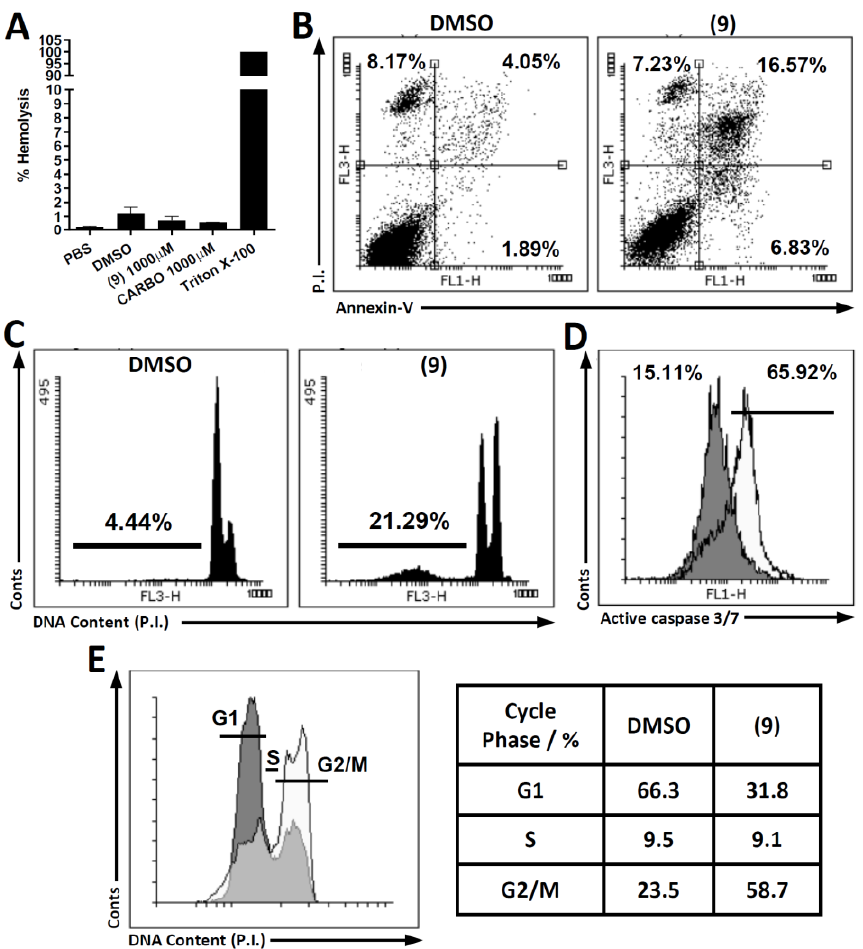
Figure 1. ( A ) Hemolytic activity of compounds at 500 µ M (approximately 10 × IC 50 ). One‑way ANOVA with Dunnett’s post‑test was performed where all columns were significantly different from the control (Triton X) with p < 0.0001. ( B ) Analysis of phosphatidylserine exposure 48 h after plating. Cells were stained with annexin‑V conjugated to FITC and P.I. and were analyzed by flow cytometry. ( C ) Analysis of cell death by propidium iodide (PI) staining. After 48 h of treatment, cells were trypsinized and stained with propidium iodide in the presence of NP‑40. The percentage of cell death (SubG0 DNA content) is indicated. ( D ) Flow cytometry data representative of caspase 3/7 activity. SCC9 cells were treated with the equivalent of 2 × IC 50 of compound 9, and DMSO was used as a control for 48 h of treatment. The activity of caspase 3/7 of the cells increased significantly under 9 treatment compared to the control. ( E ) Differences in cell cycle distribution. Cell cycle distribution was analyzed after propidium iodide staining and FACS analyses. SCC9 lineage cells were plated in a six-well plate (5 × 10 5 cells/well). The phases G1, S, and G2 of the cell cycle were classified based on the DNA content after staining with propidium iodide (PI). ( A – E ) Results are representative of data from at least three independent experiments.